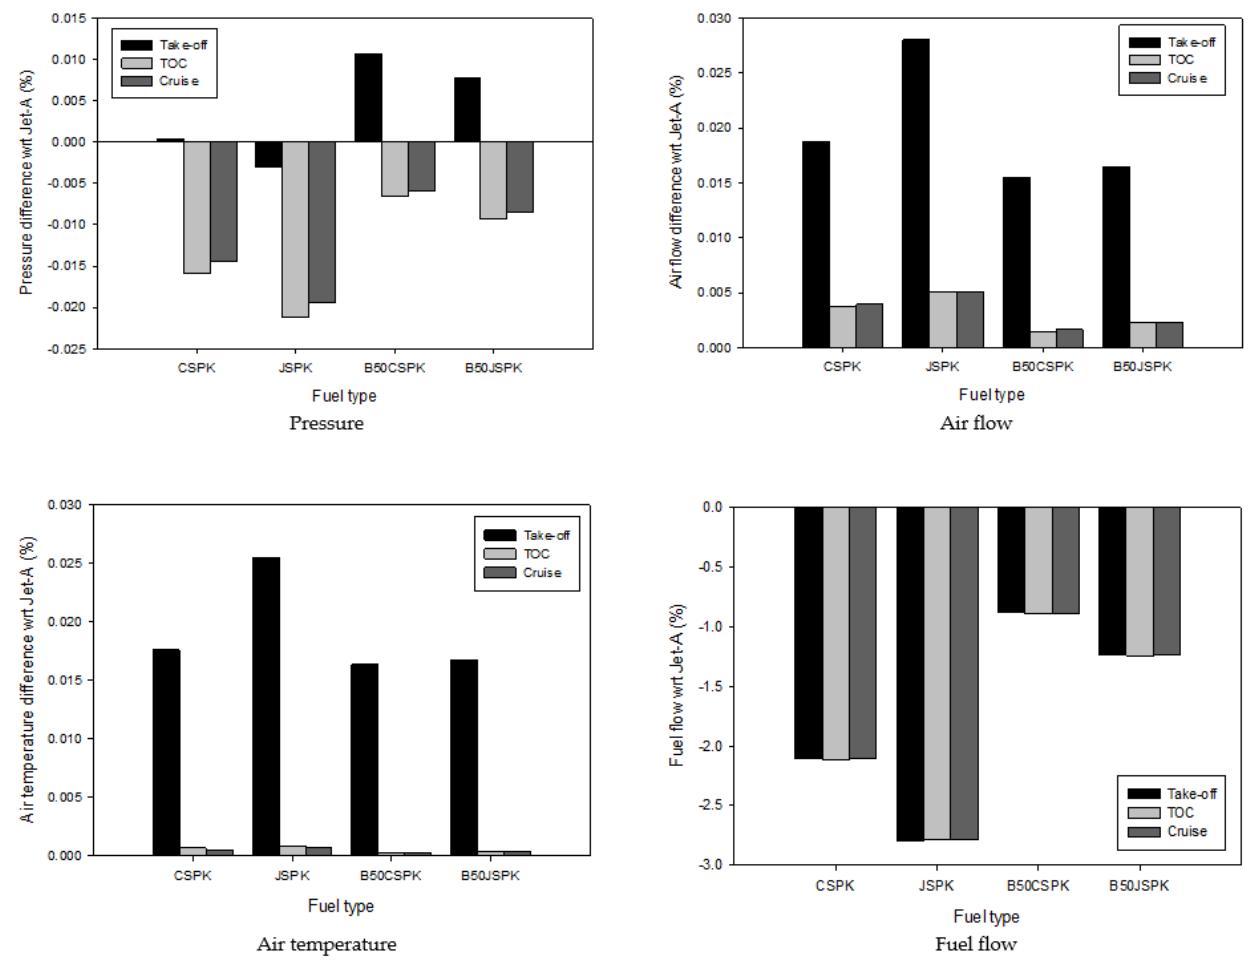
Figure 3. Comparison of pressure, airflow, air temperature, and fuel flow of biofuels with Jet–A.